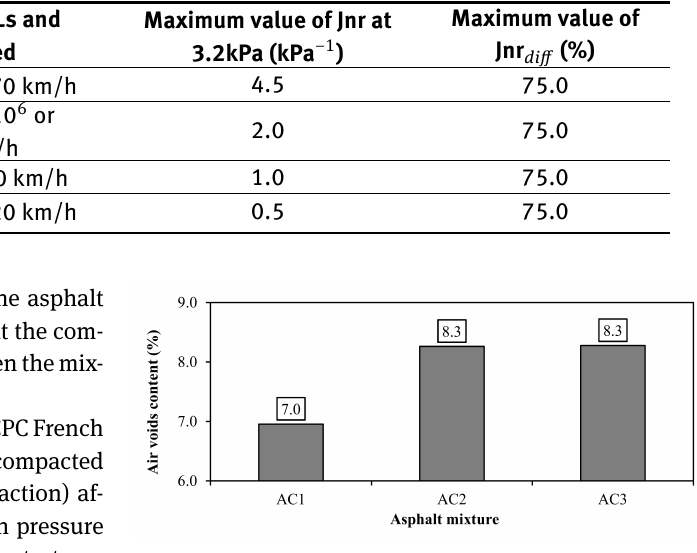
Figure 8: Air voids